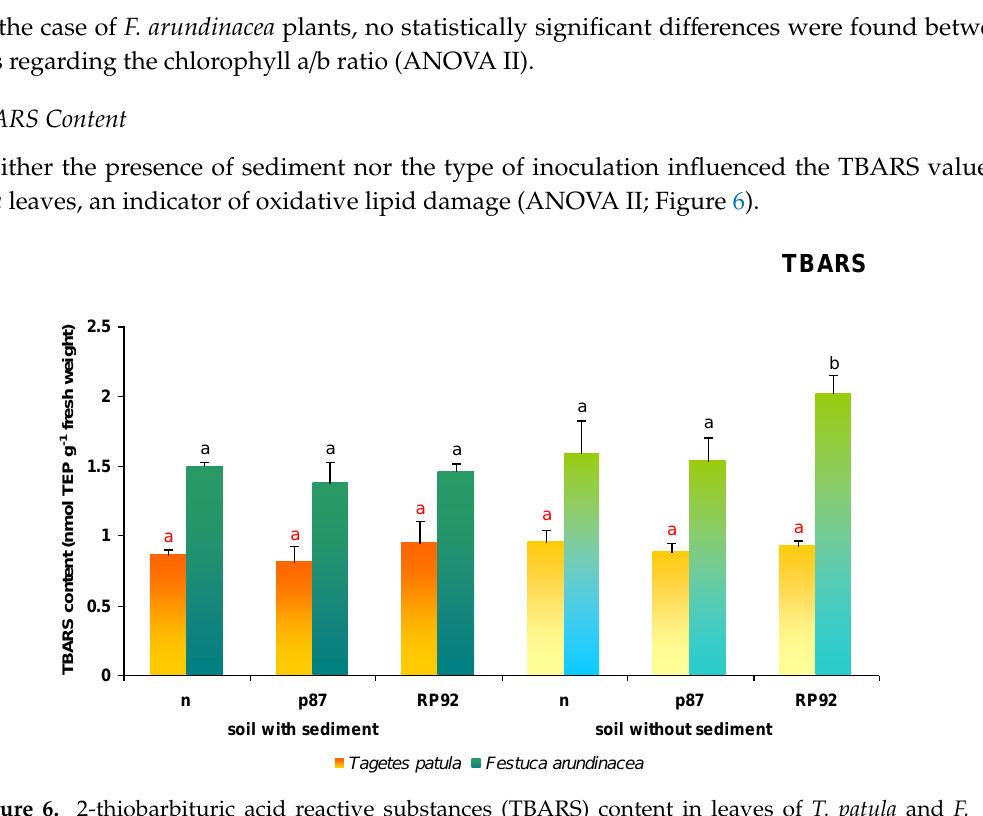
Figure 5. Chlorophyll a/b ratio in leaves of T. patula and F. arundinacea grown on control and bottom sediment-amended soil with or without (n) inoculation with bacterial strain p87 or RP92. The same letters denote groups that did not significantly differ (at p < 0.05; the Duncan post hoc test). Statistical significance was measured for each plant separately and the results were marked by different colors.